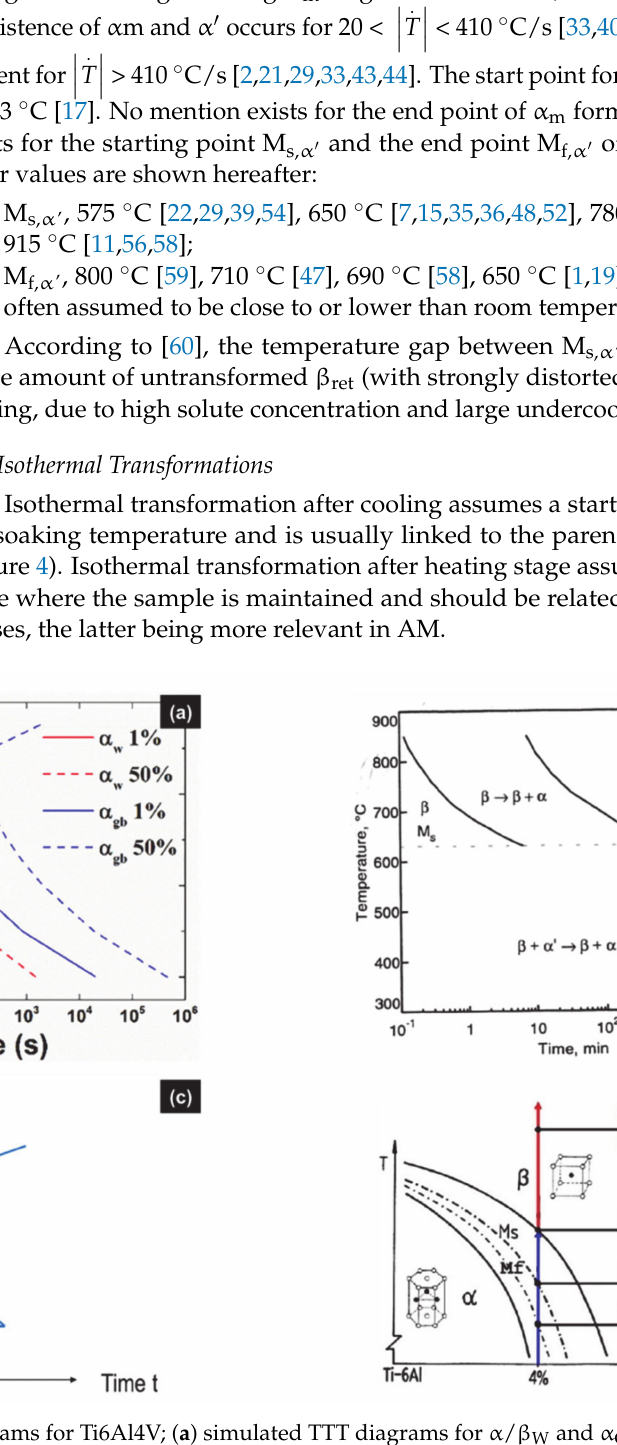
Figure 4. Examples of TTT diagrams for Ti6Al4V; ( a ) simulated TTT diagrams for α / β W and α GB (respectively annotated α α β . (reprinted from ref. [56]); ( b ) TTT diagram of W and GB ) resulting from the diffusional phase transformation of Ti6Al4V after solution annealed at 1020 ◦ C and direct quenching to reaction temperatures showing DDfT and DDsT and M s, α ’ at 625 ◦ C (reprinted from ref. [63]); ( c ) sketch of a TTT diagram plotting both a diffusional transformation (D) and a martensitic transformation (M), with their related starting curves D s and M s , and the finishing curves D f and M f (reprinted from ref. [56]); ( d ) schematic pseudo-binary diagram of Ti6Al4V showing equilibrium metastable phase fields, with their related crystal structure and transition points (reprinted with permission from ref. [19]. Copyright 2019